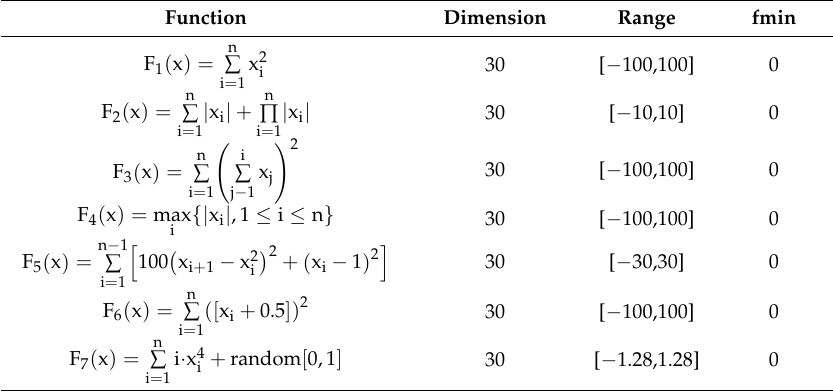
Table 2. Unimodal test functions with dimensions = 30.